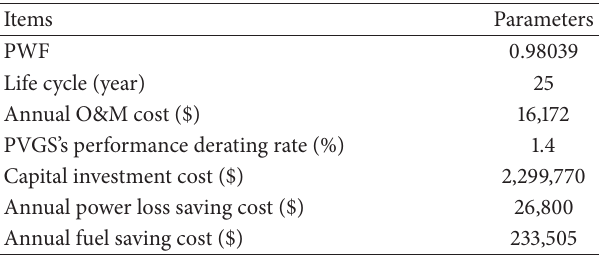
Table 1: Parameters of the financial evaluation.